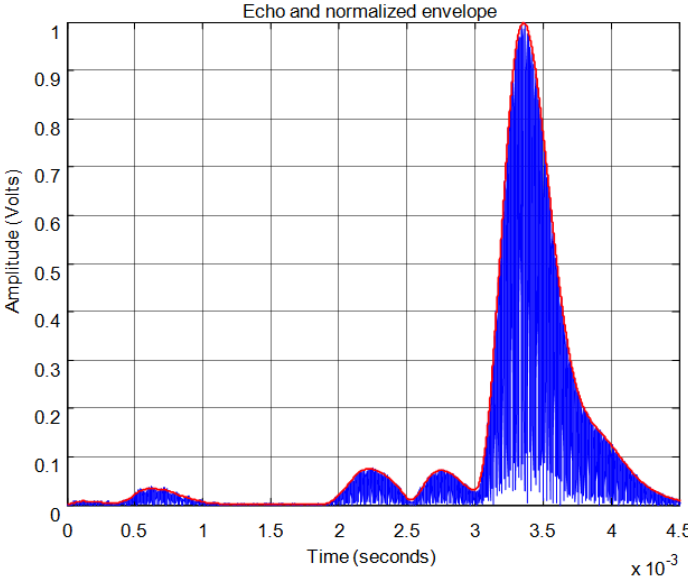
Figure 26. Normalized echo and envelope for an echo formed by three overlapping sub-echoes.